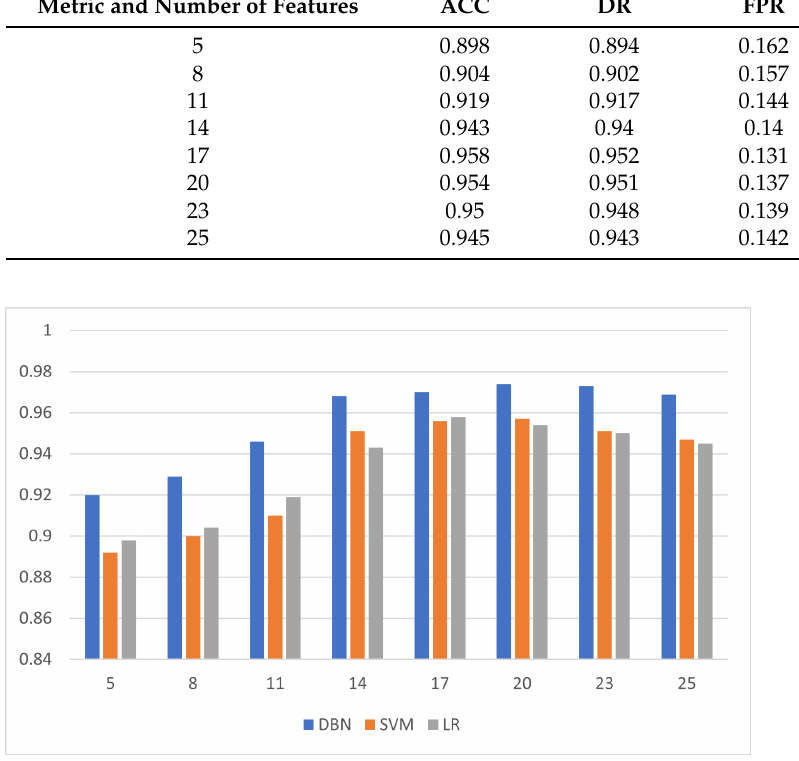
Figure 1. Comparison of the proposed ADBN-IDS with SVM and LR in terms of detection